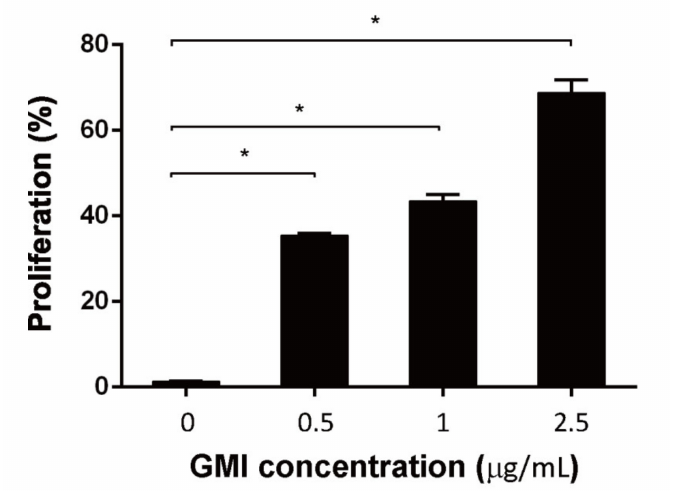
Figure 4. Enhancement of T cell proliferation by GMI. T cells were incubated with GMI for 48 h. T cells were then enumerated by flow cytometry. The results were analyzed statistically with Student’s t -test. *: p < 0.05.